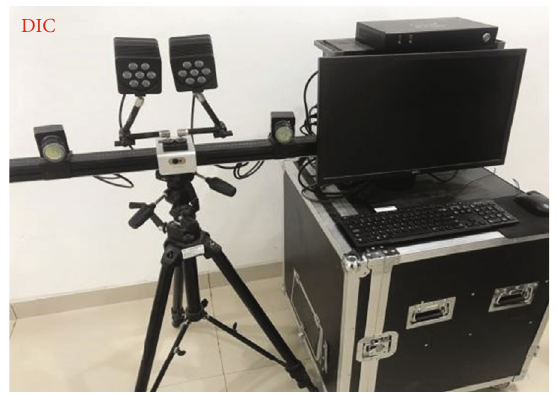
Figure 22: Experimental monitoring system.